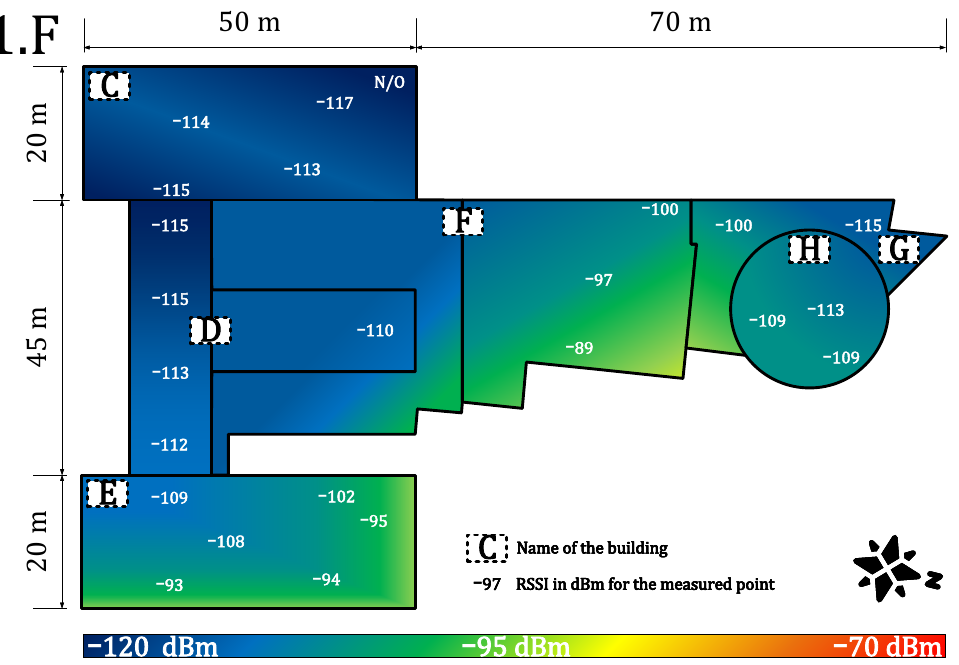
Figure 12. Public network coverage and signal propagation on the third floor.